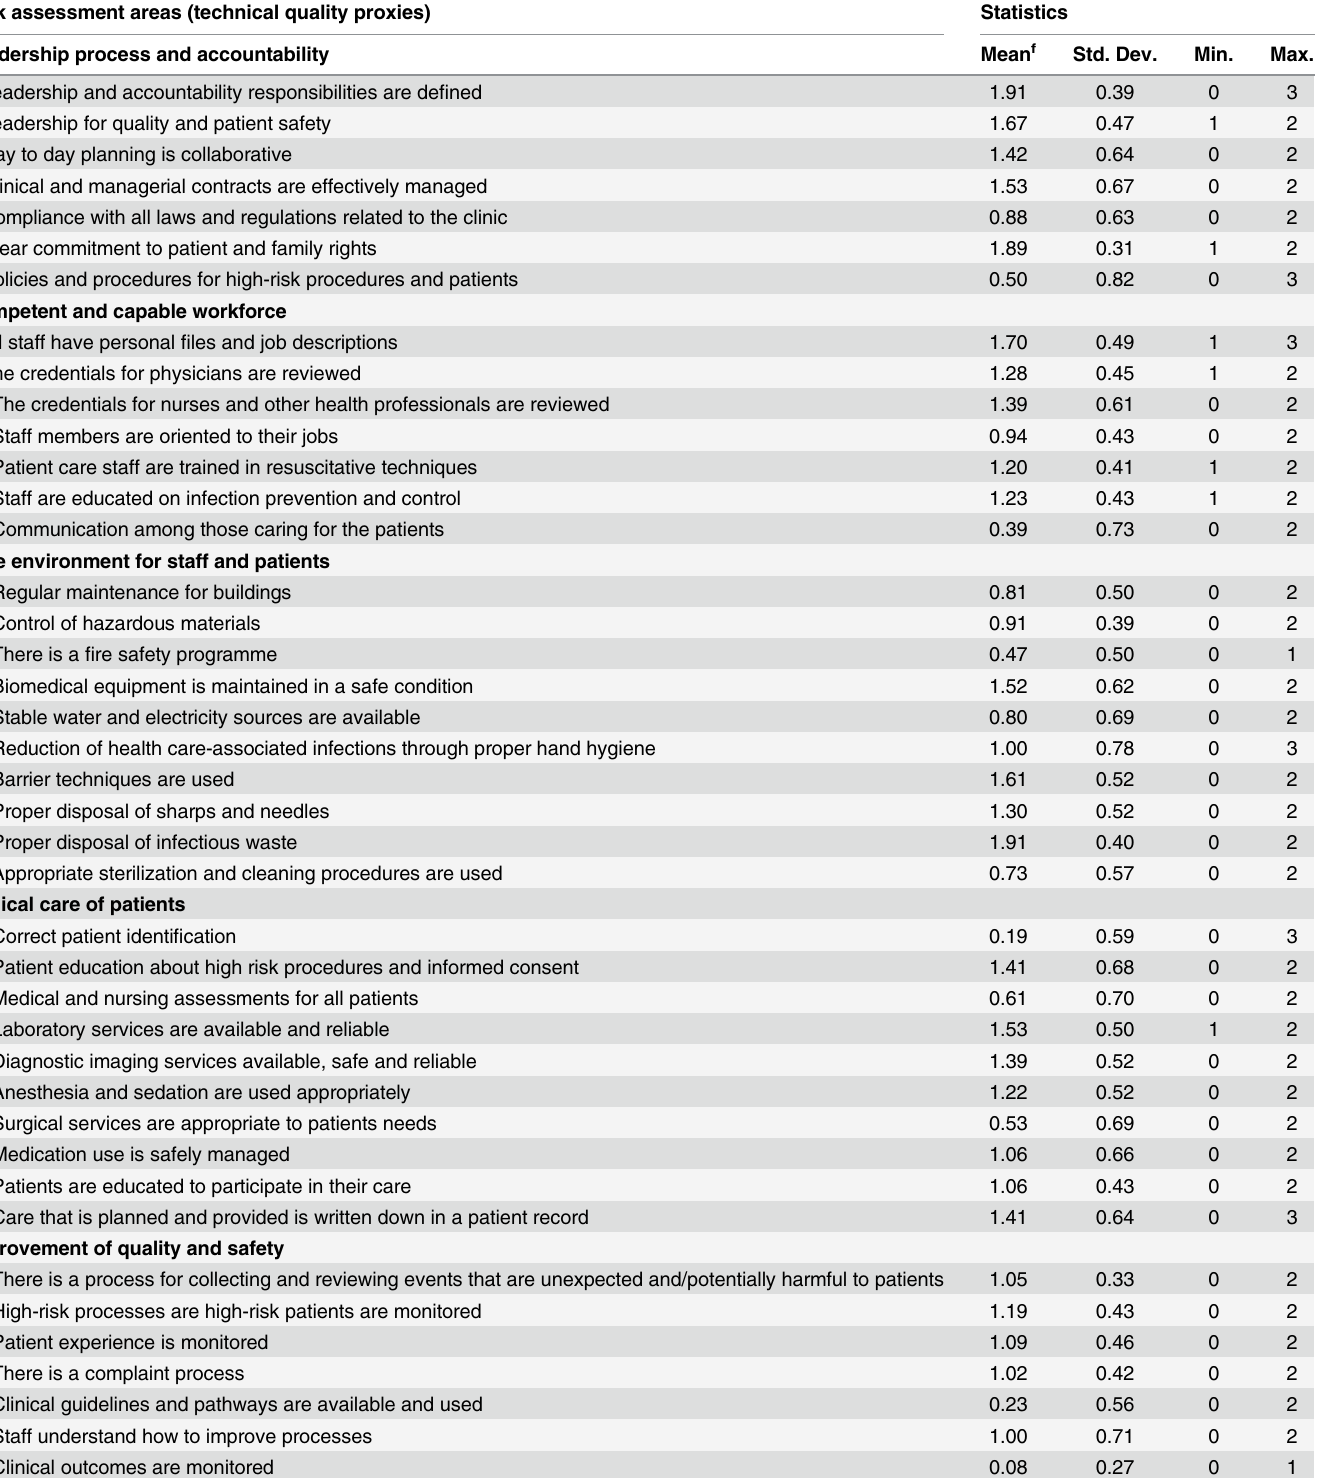
Table 3. Average score per technical quality care proxy (n =